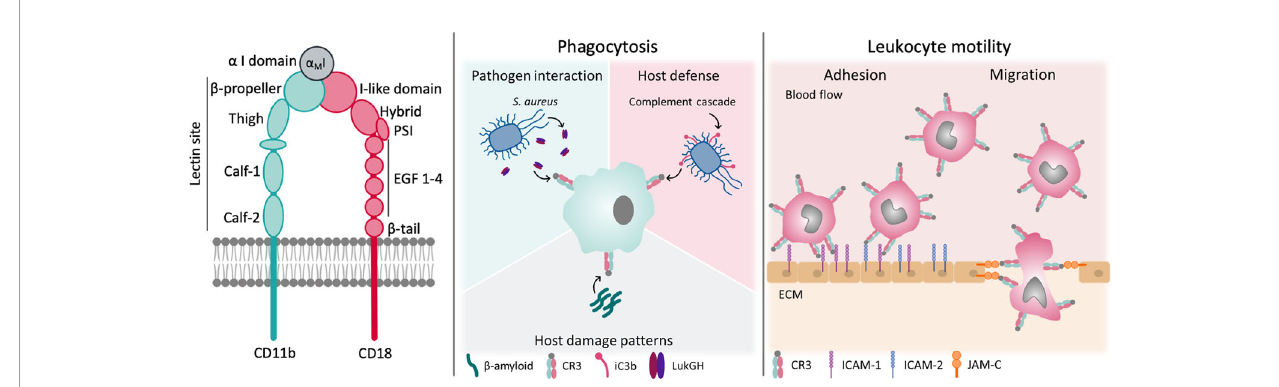
FIGURE 1 | Structure and function of CR3. CR3 exerts a broad variety of functions in host-defense and leukocyte motility. Some of them are